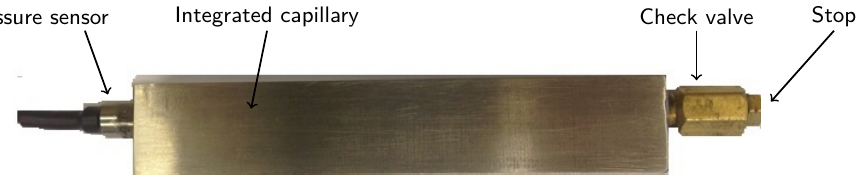
Figure 2. Fully equipped Ti-6Al-4V specimen with installed pressure sensor at one side and check valve and stop at the other side. The eSHM system is